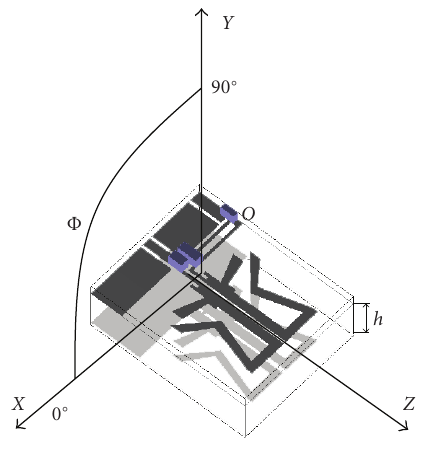
Figure 3: The XOY plan where the directive gain was measured for the experimental antenna.